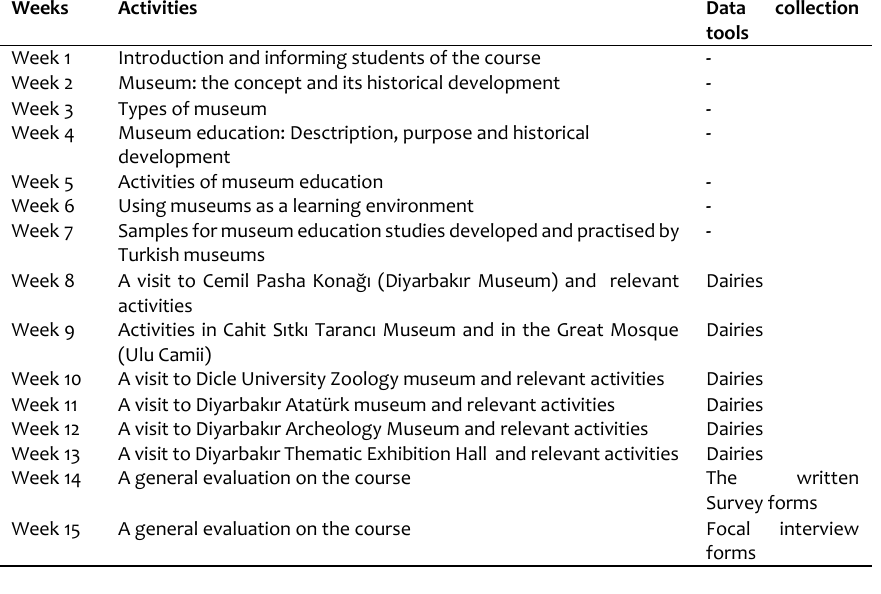
Table 1. The Process of